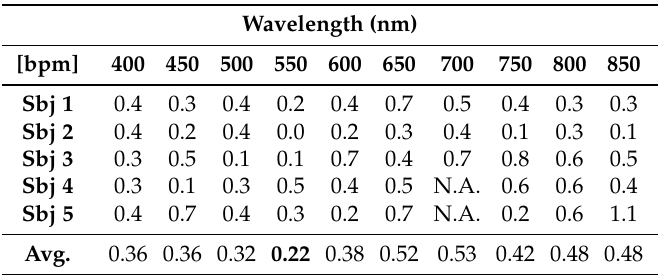
Table 5. Respiration rate errors between the SPAD estimation and the ECG ground truth one. Bold values represent best results.